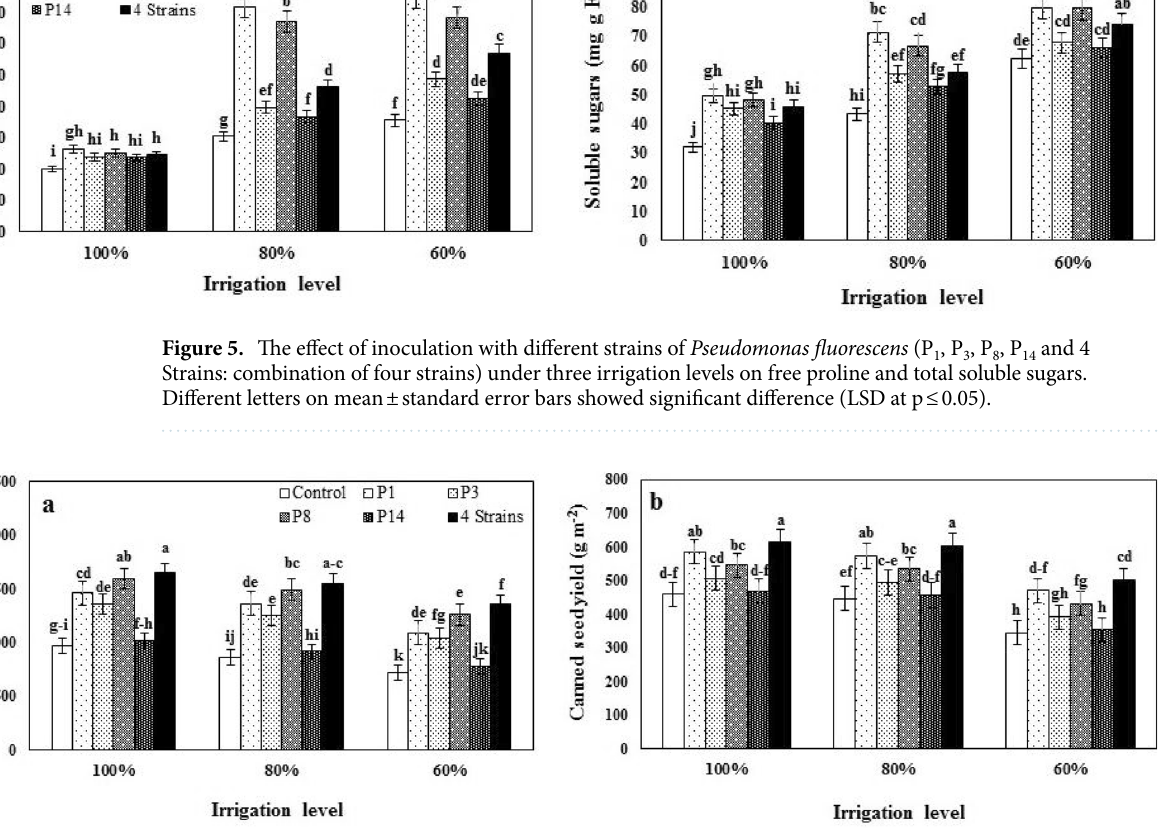
Figure 6. The effect of inoculation with different strains of Pseudomonas fluorescens (P 1 , P 3 , P 8 , P 14 and 4 Strains: combination of four strains) under three irrigation levels on ear yield (Ear Y) and canned seed yield (Canned SY). Different letters on mean ± standard error bars showed significant difference (LSD at p ≤